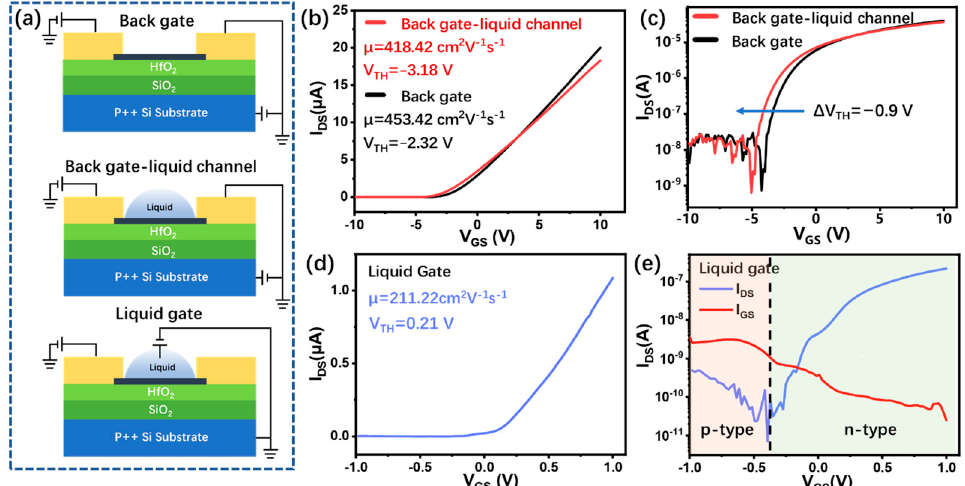
Figure 2. ( a ) Schematic diagram of the three operating modes of InSe-FET. Comparison of InSe-FET performance before and after filling the microfluidic channel with liquid in ( b ) linear and ( c ) logarithmic coordinates. Transfer characteristic curves of InSe-FET regulated by liquid gate in ( d ) linear and ( e ) logarithmic coordinate systems.